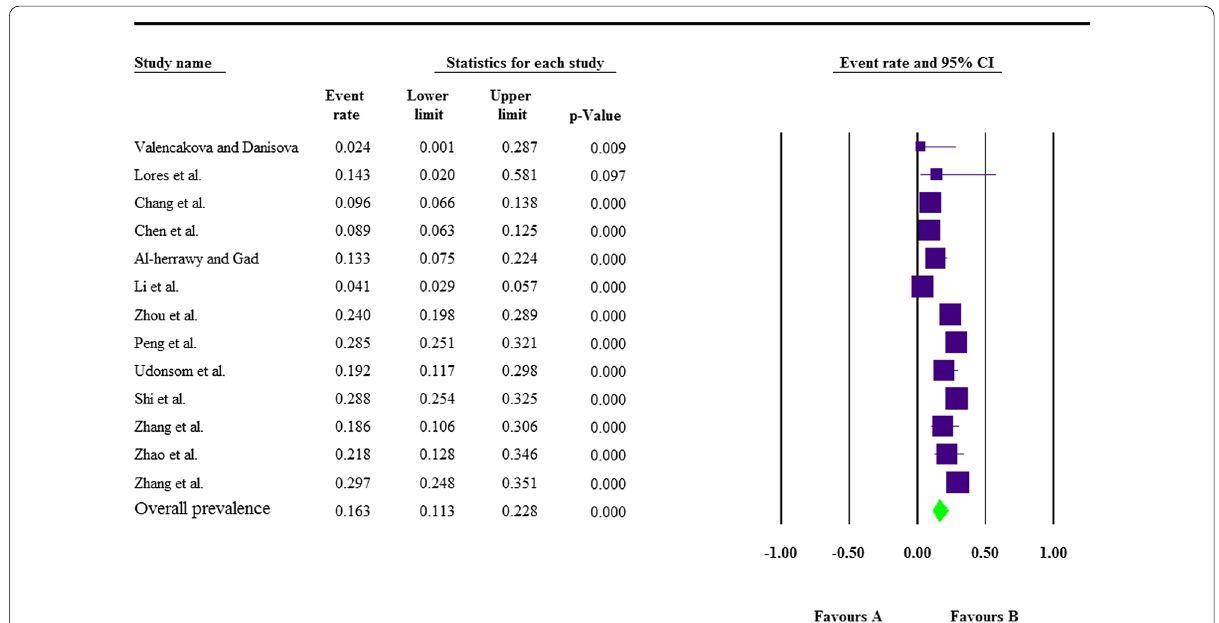
Fig. 3 The pooled molecular prevalence of E. bieneusi infection in goats